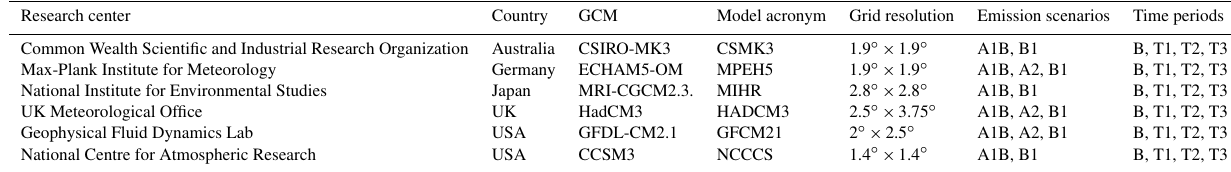
Table 1. Selected global climate models from IPCC AR4 incorporated into LARS-WG. Research center Country